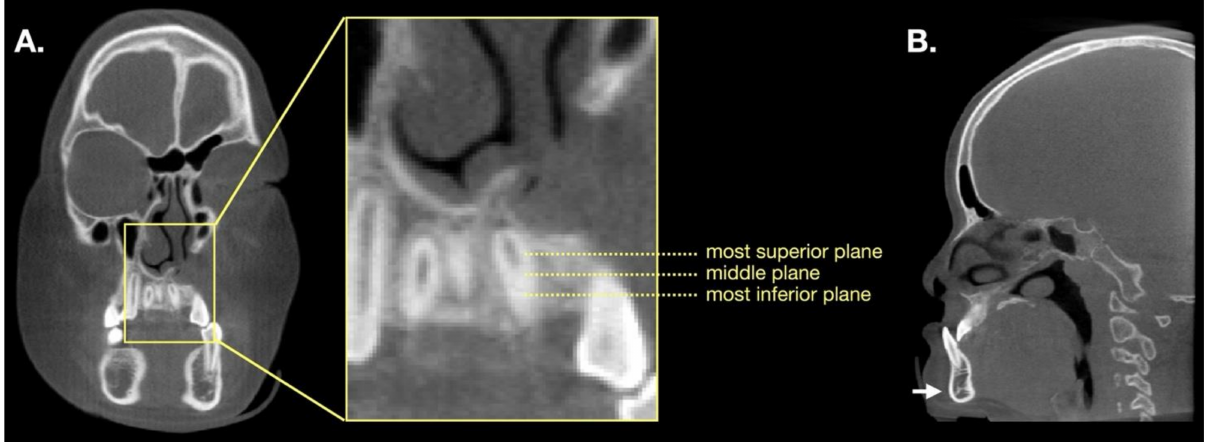
Figure 1. Identification of the selected planes. ( A ) Identified the most superior and inferior planes transecting the grafted tissue on the coronal view image; subsequently, the middle plane of the grafted tissue was identified. ( B ) The pogonion was identified on the sagittal view.